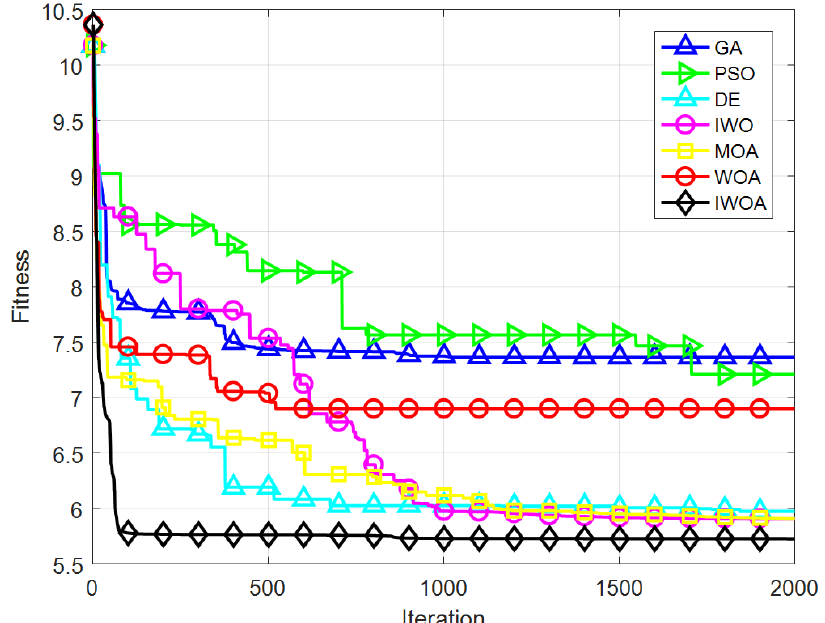
Figure 10. Convergence rates of the 64-element planar phased array.